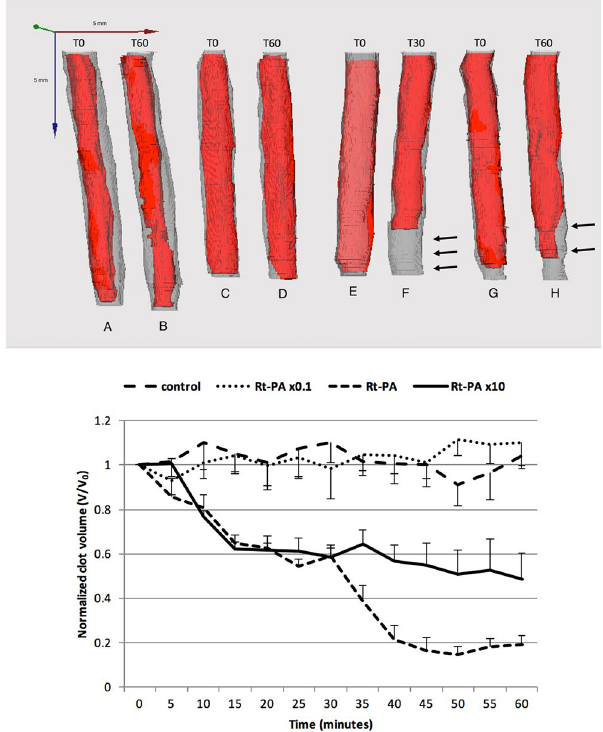
Figure 4. Thrombolytic efficacy of in vitro after Rt-PA delivery in the stenosis model. Blood clots were treated with a range of Rt-PA alone in a range of concentrations (0, 0.3, 3, 30 µ g/ml). The blood clot volume was assessed every 5 min for 60 min using high frequency ultrasound imaging. 3D reconstruction of clots was performed at T0 and T60 (Top), except for the Rt-PA condition (T30) as the clot was almost lysed at T60. A, B Rt-PA x0,1; C-D: control; E-F: Rt-PA; G-H: Rt-PAx10 (Arrows indicating the lysis of the clot). Video 1 is showing the clot volume at T0 and T30 in the Rt-PA condition. Data expressed as mean ± SEM were calculated from four independent experiments